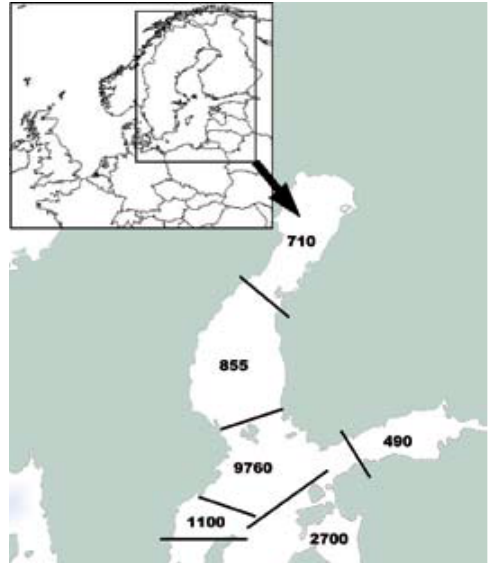
Fig. 3 . The spatial distribution of 15,950 grey seals during moult in May-June in the Baltic Sea in 1996. Data are from 2003 and typical for years with a mild winter and limited ice formation. The numbers represent maximum numbers from many smaller localities accumulated over several weeks, therefore these figures are likely to represent a large propor - tion of the true population.